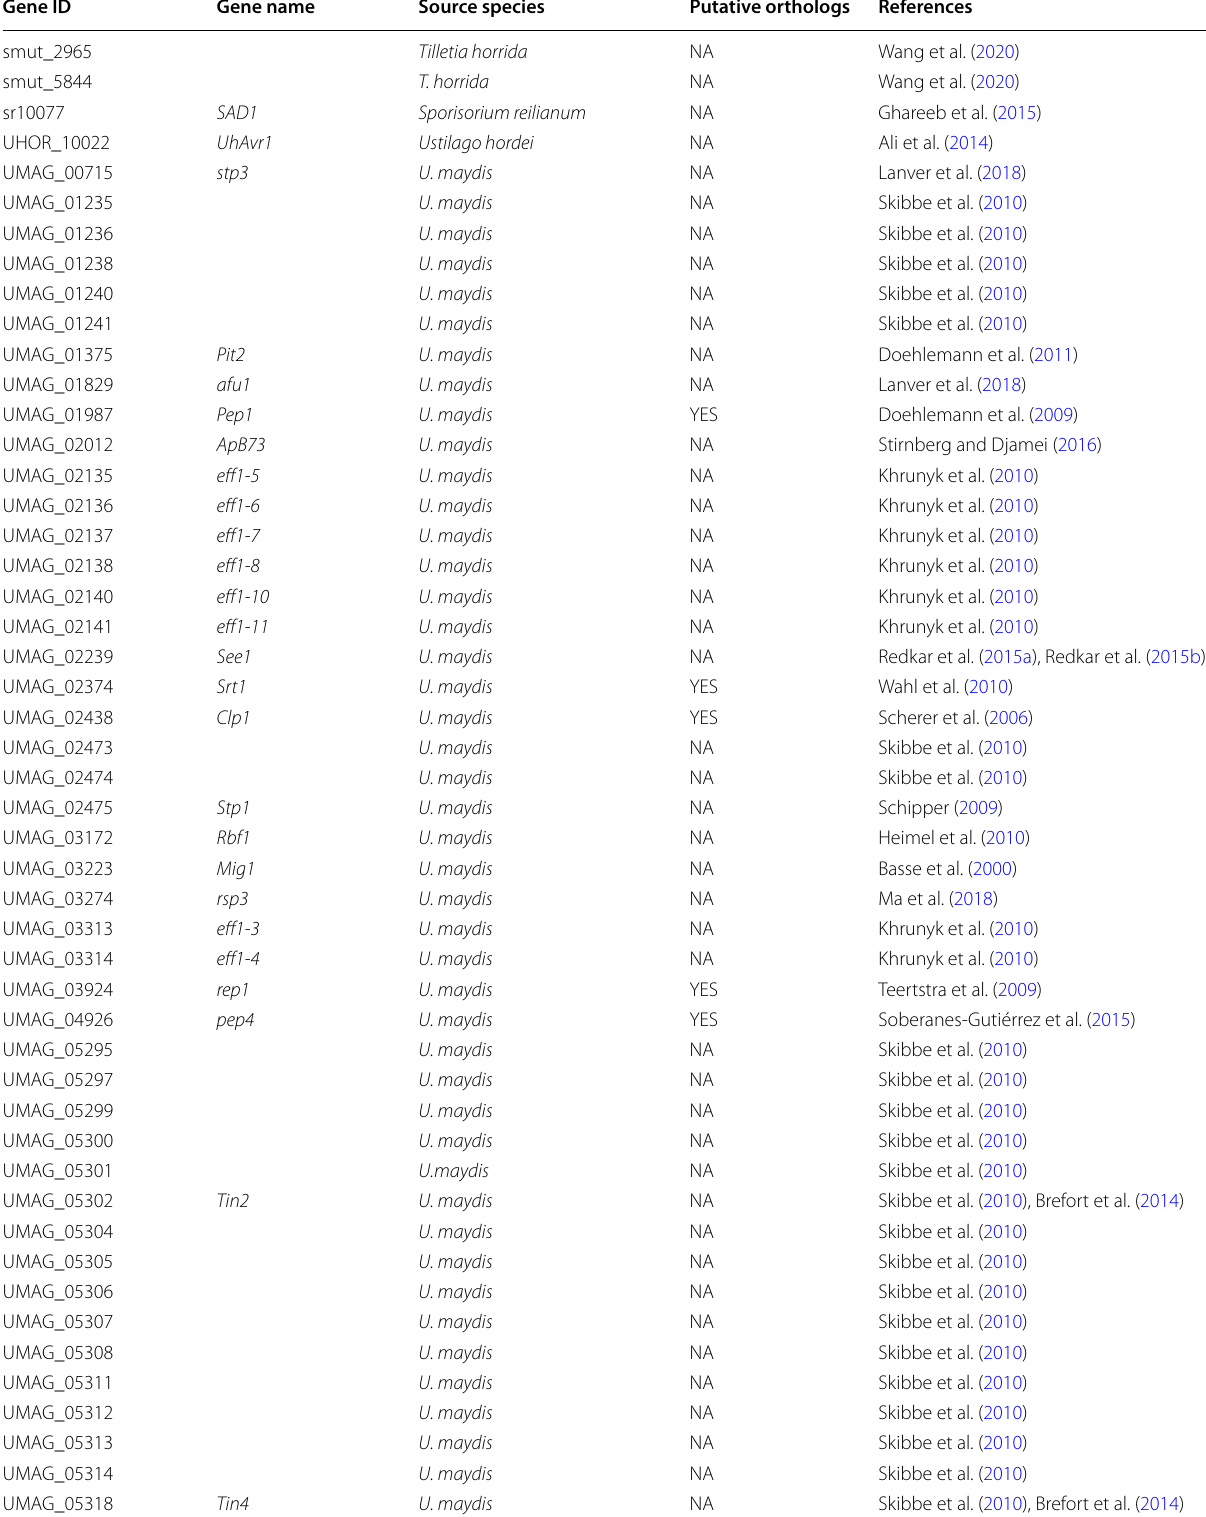
Table 3 Functionally characterized genes involved in pathogenicity, life cycle, and